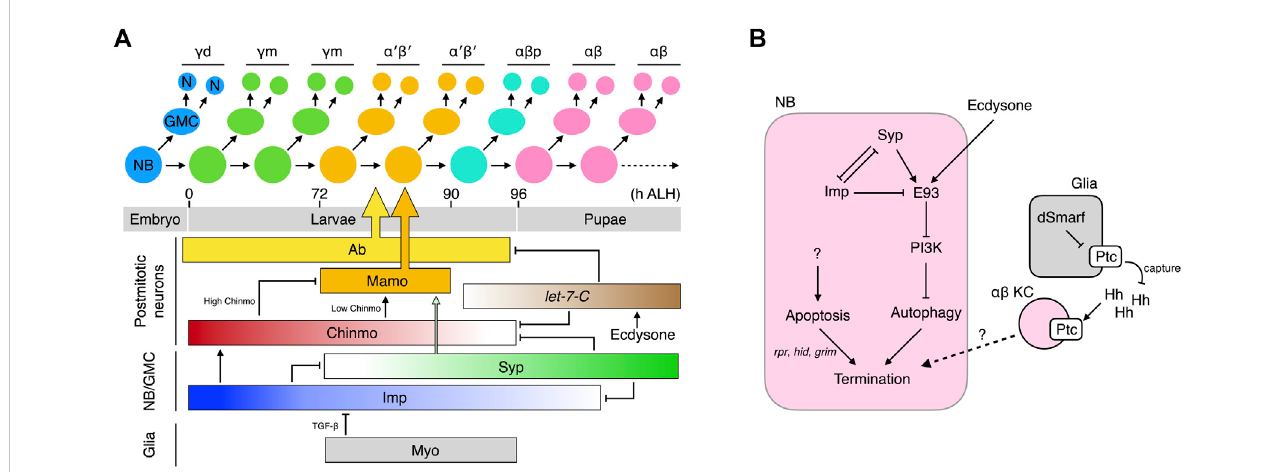
FIGURE 2 Temporalspeci fi cationofKCsandterminationofMB-NBs. (A) ProductionandbirthorderofKCtypes.Themolecularnetworkthatspeci fi estheKCtypes is shown. Ab and Mamo speci fi cally instruct speci fi cation of the α ′ β ′ KCs. They are regulated by multiple temporal factors that cooperate to also dictate speci fi cation of other KC types (B) Molecular networks that promote the termination of